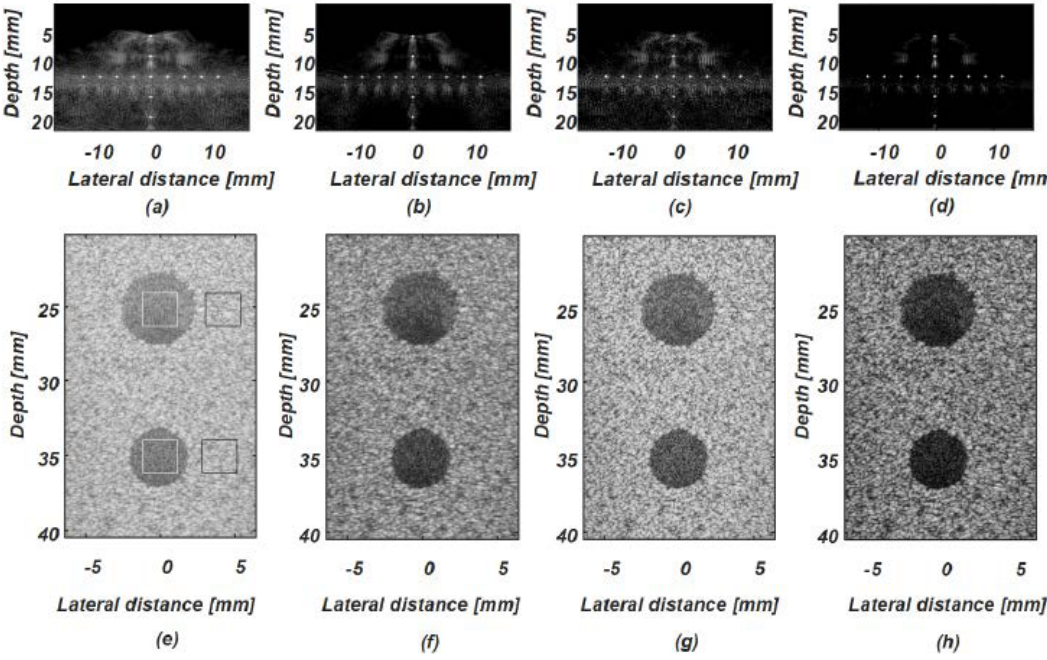
Figure 3. Simulated point targets and cyst images of different methods ( a ) ( e ) DAS, ( b ) ( f ) sSCF, ( c ) ( g ) aSCF, ( d ) ( h ) uSCF. All images are shown in a 70 dB dynamic range.